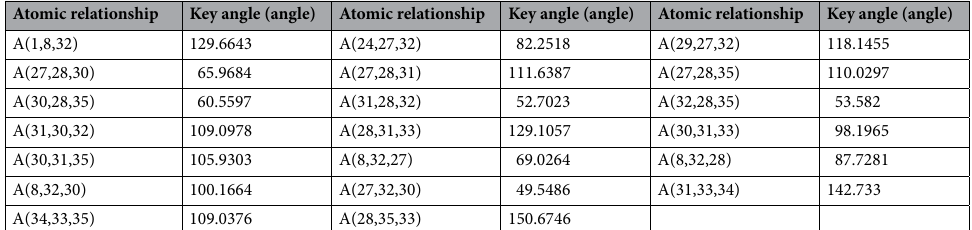
Atomic relationship